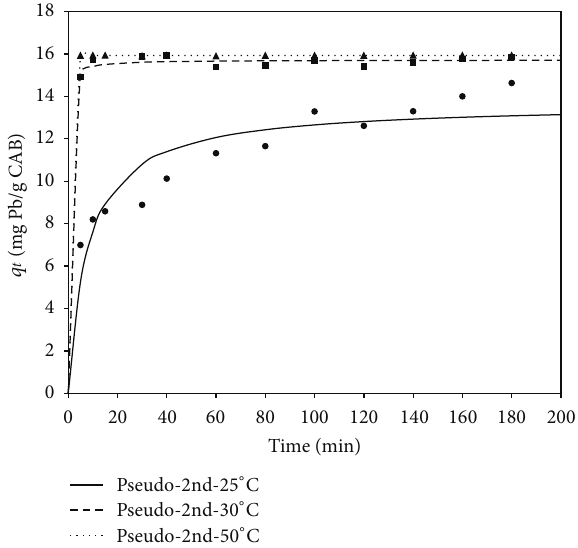
Figure 3: Adsorption capacity ( 𝑞 𝑡 ) of cadmium by CAB at different temperatures ( ∘ C) versus time (min), adjusted to a pseudo-second- order model.